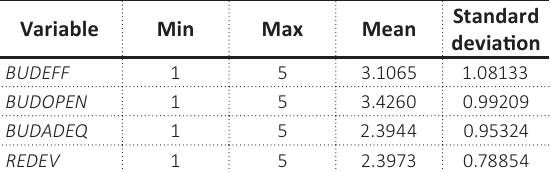
Table 3. Descriptive statistics for